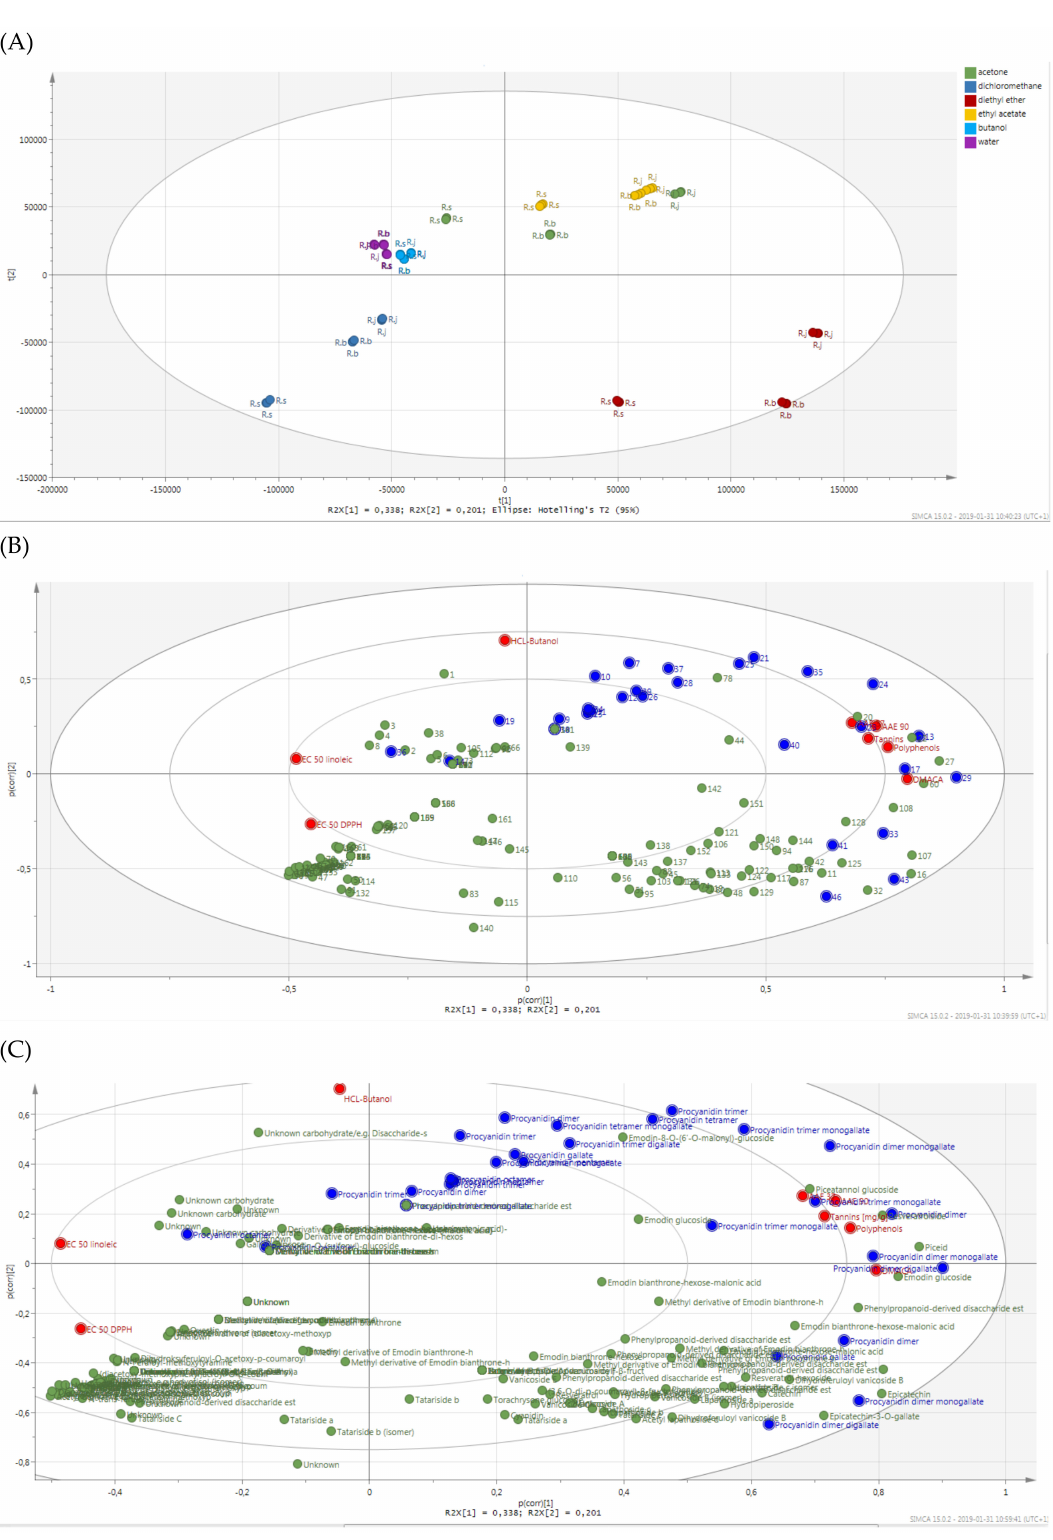
Figure 10. DPPH free radical scavenging activity of vanicoside A, vanicoside B, R. sachalinensis acetone extract and R. sachalinensis ethyl acetate fraction with range of concentrations. SC% percentage of scavenging activity on DPPH radical. The absorbance at 517 nm was measured after 30